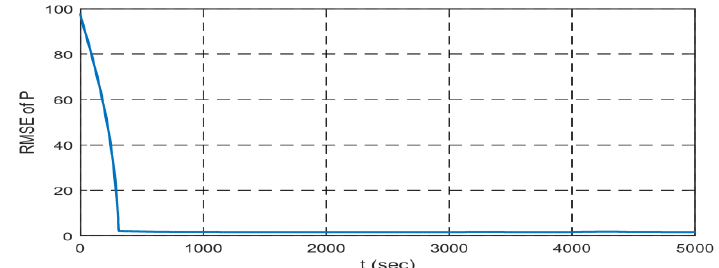
Figure 35. Evolution of P during sea state change using Modified TF and Adaptive R.